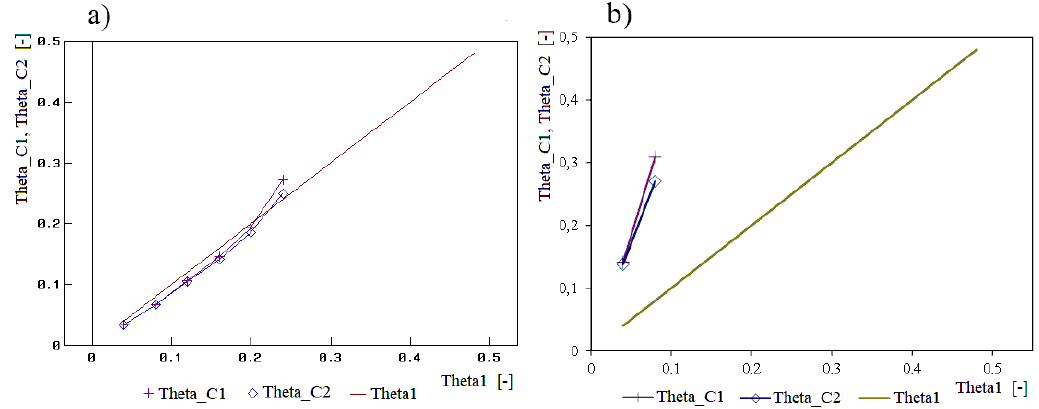
Figure 6: Values of diagnostic parameters ϑ C 1 (Theta_C1) and ϑ C 2 (Theta_C2) as functions of the dimensionless coeflcient of damping in the suspension system ϑ 1 (Theta1), obtained from an analysis of the factor of gain in the vertical force at the tire-exciter contact point (relative to the input force) close to the first natural frequency of the front “quarter car”: a) results for the linear model; b) results for